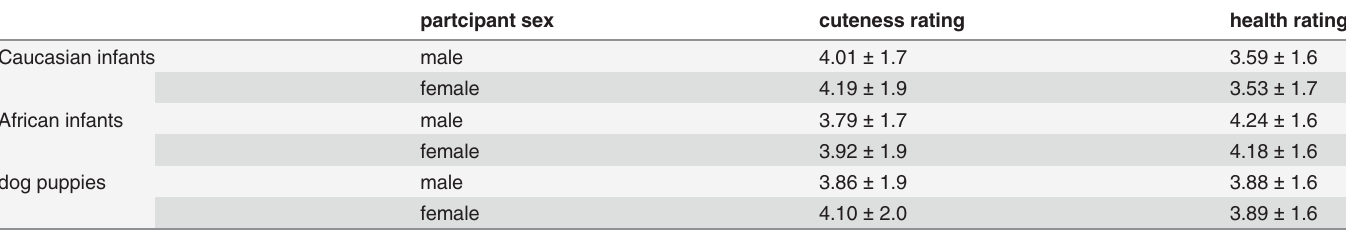
Table 7. Descriptive statistics of Study 2.